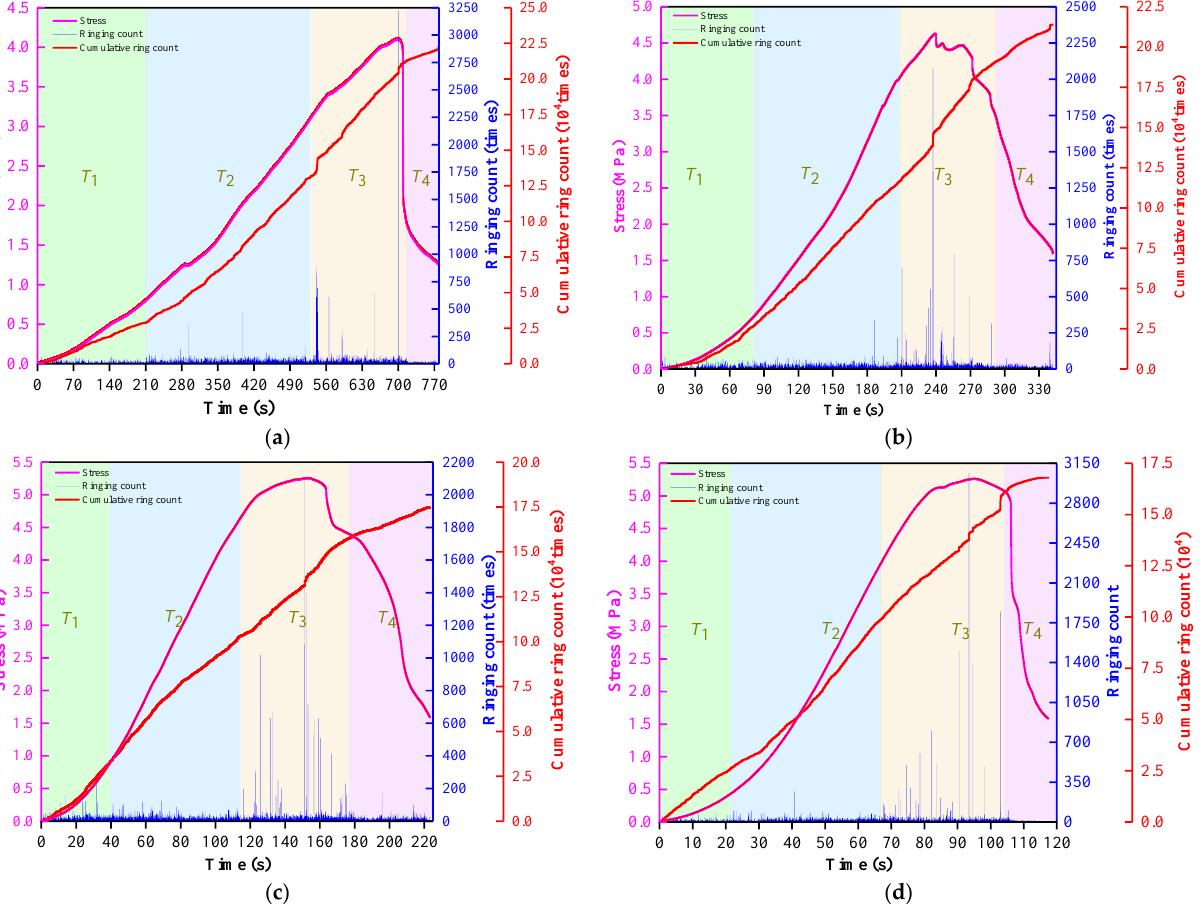
Figure 7. AE ringing counts, stress and time curves of ASPM specimens. ( a ) 0.002; ( b ) 0.005; ( c ) 0.0075; ( d ) 0.01.